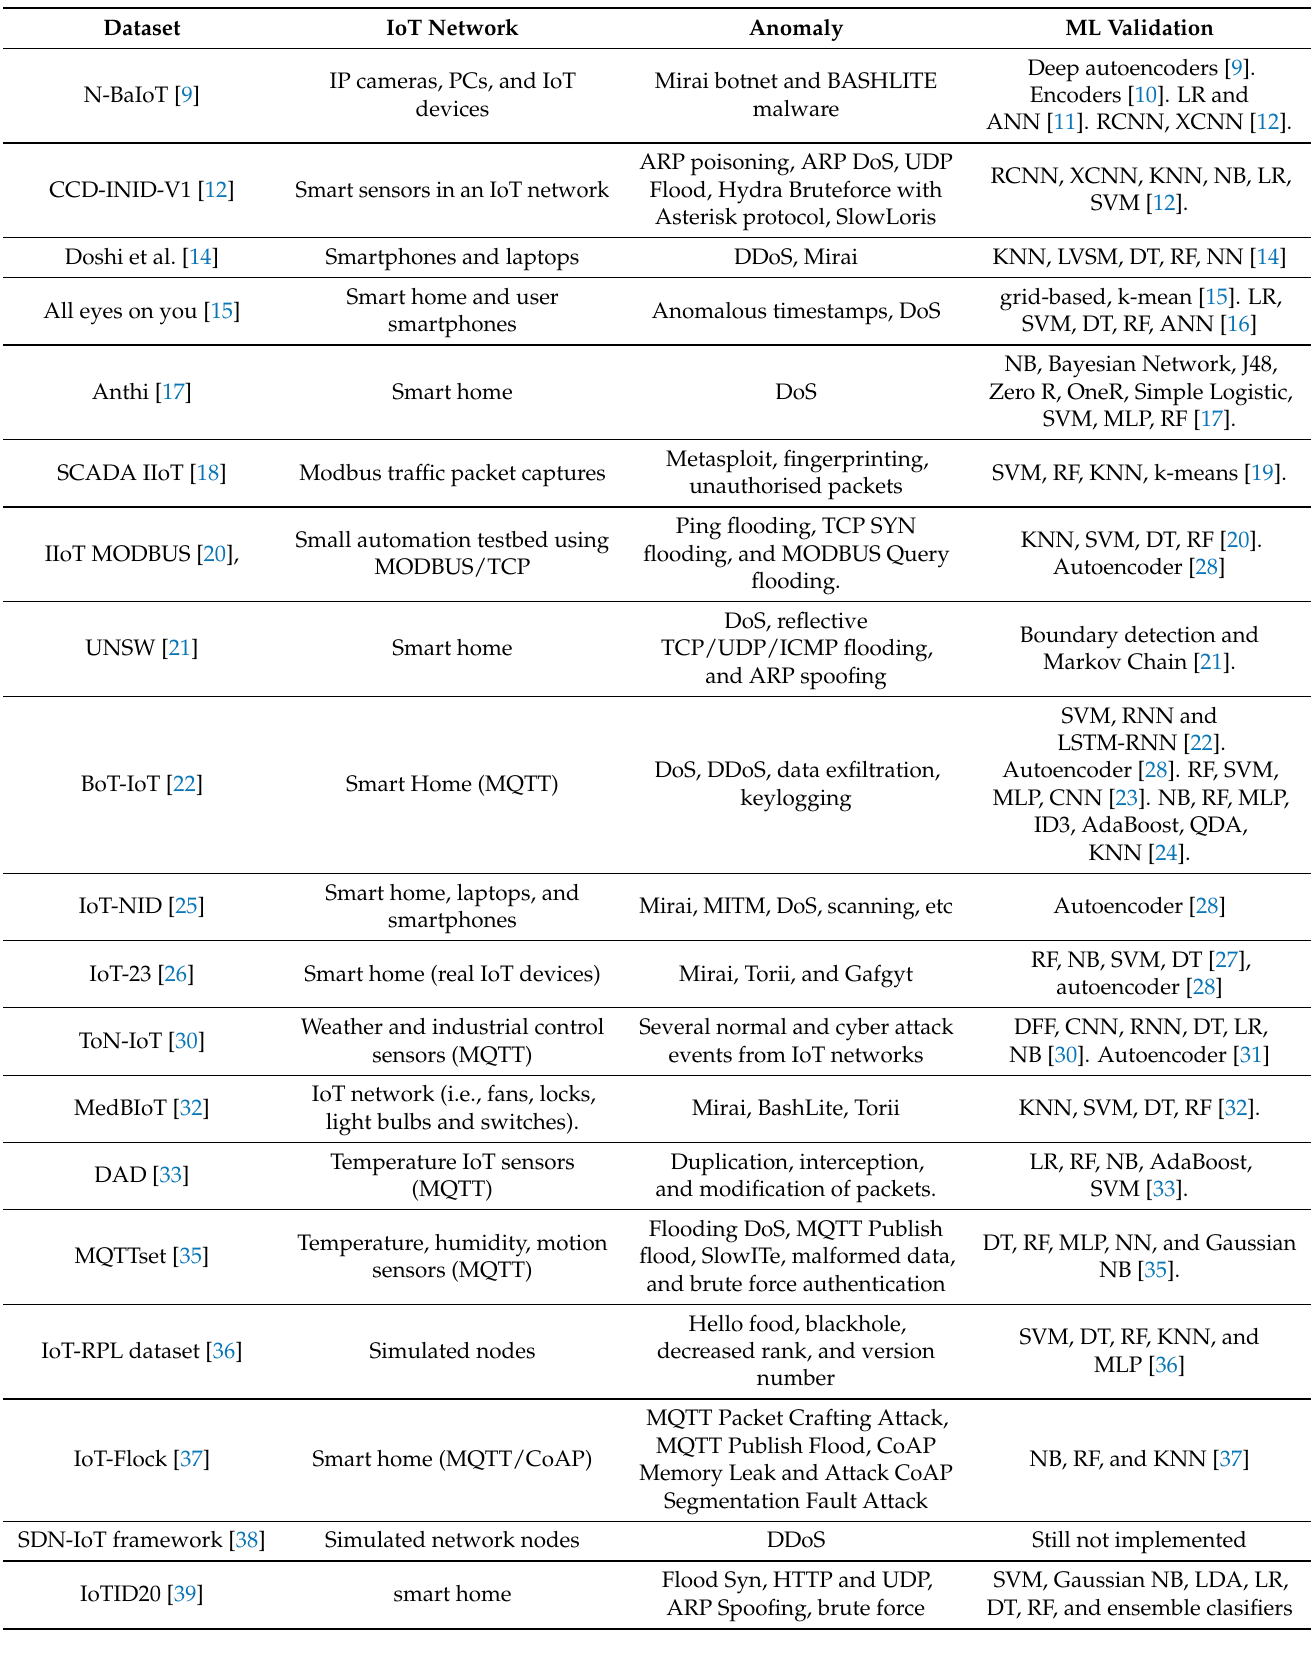
Table 1. IoT dataset review summary considering applications in